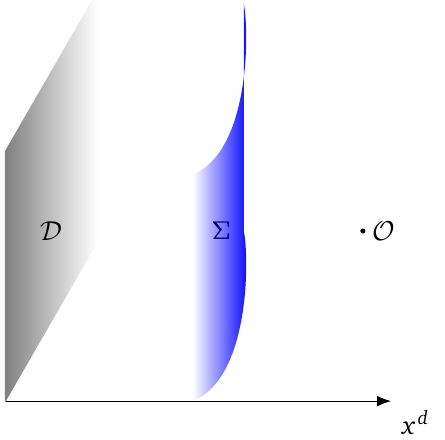
, the topological operator Q ( Σ ) and the local D